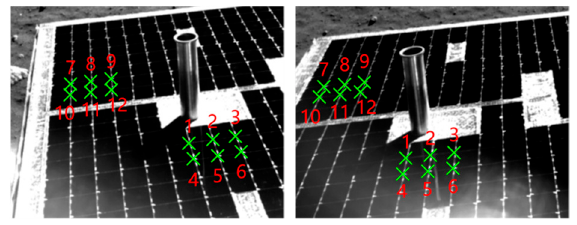
Figure 21. OSR line intersections. Table 10. Calculated OSR dimensions of solar panel and errors. Table 10. Calculated OSR dimensions of solar panel and